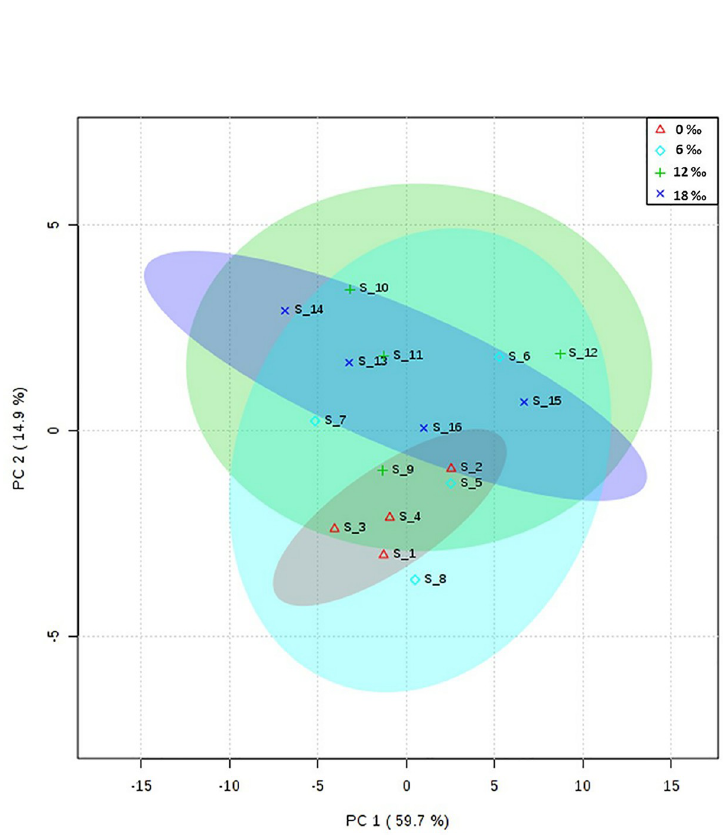
NL:PL 0.031 ± 0.006 0.028 ± 0.001 a 0.023 ± 0.001 b 0.014 ± 0.001 c 0.018 ± 0.001 bc Data are presented as mean ± SE (n = 2). Within the male and female groups, values within the same row with different supesrcipt letters (capital letter for males and lower case letter for females) indicate significant difference; NL: neutral lipids; PL: polar lipids ratio.